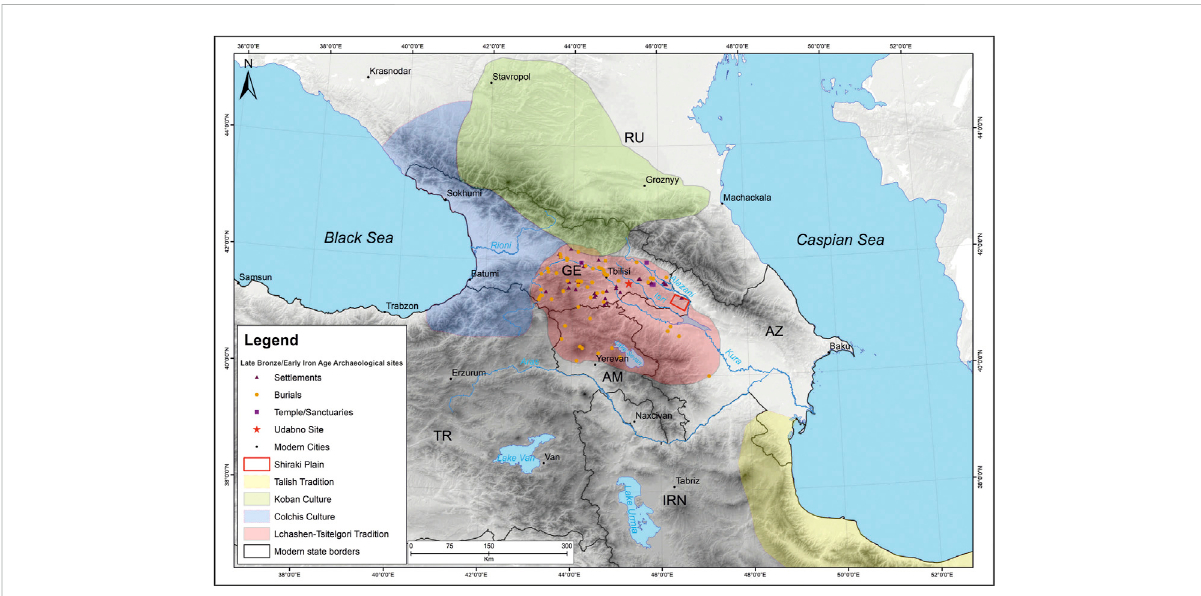
FIGURE 1 TheCaucasusregion withthedistributionofLateBronze/EarlyIronAgecultures(Sagona,2018).The ShirakiPlainisshownwitharedrectangle, andtheUdabnoregionwithsimilarecologicandclimaticconditionsaswellasasimilarprehistoricsettlementhistorywitharedstar.Thetopography is based on an SRTM DTM (http://www2.jpl.nasa.gov/srtm) [GE = Georgia, RU = Russia, AZ = Azerbaijan, AM = Armenia, TR = Turkey, IRN = Iran].